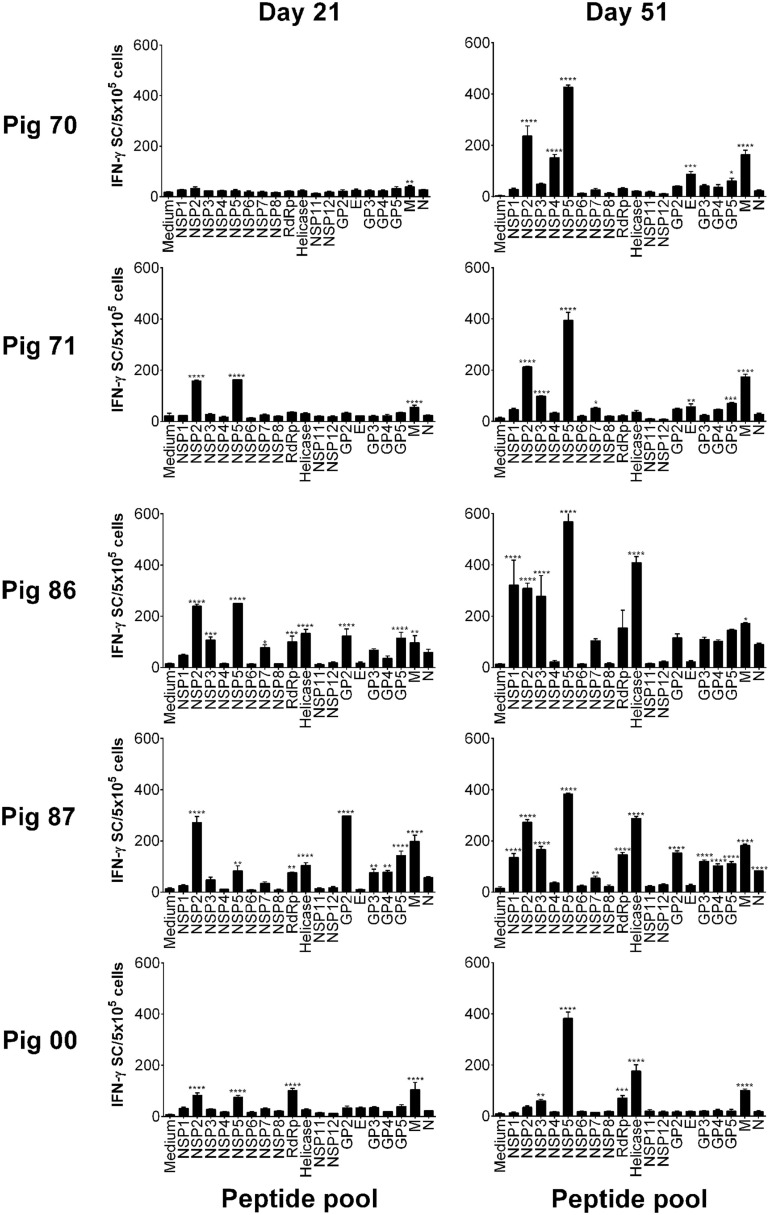
Recognition of PRRSV-1 proteins by T cells from pigs experimentally infected with the Olot/91 strain. PBMC from pigs experimentally infected with PRRSV-1 Olot/91 (n = 5) were isolated on day 21 and day 51 postinfection (16 days post-challenge), and stimulated in vitro with synthetic peptides pooled to represent 19 PRRSV-1 proteins. IFN-γ secreting cells were enumerated by ELISpot assay. Data are presented as IFN-γ spot forming cells (SFC)/5 × 105 PBMC (triplicate cultures) for each animal and error bars show the SEM. Values for each peptide pool-stimulated condition were compared to the corresponding unstimulated (medium) control using a one-way ANOVA followed by a Dunnett’s multiple comparison test; ***p < 0.001, **p < 0.01, and *p < 0.05.